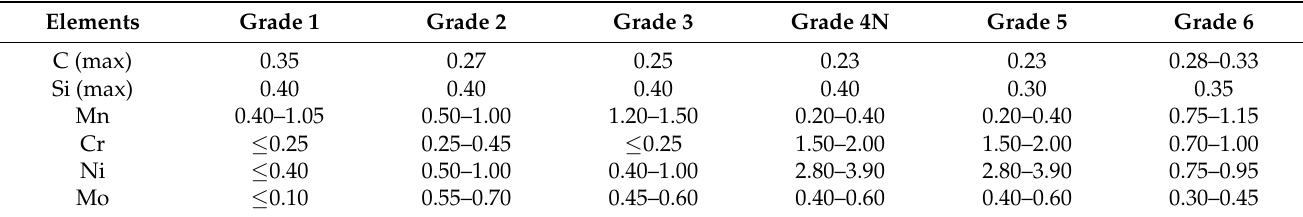
Table 2. The chemical composition of A508 series steel (wt.%) [24].